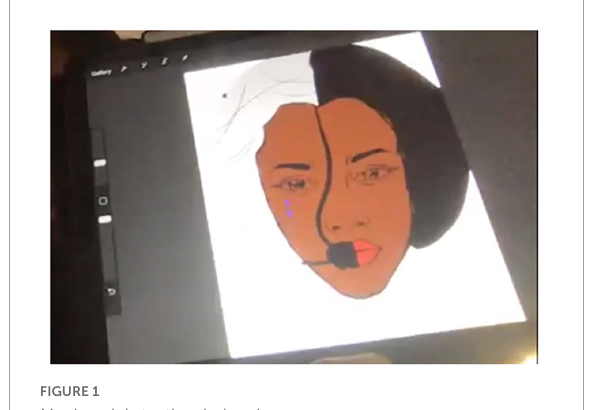
FIGURE1 Mackenzie’s textbook